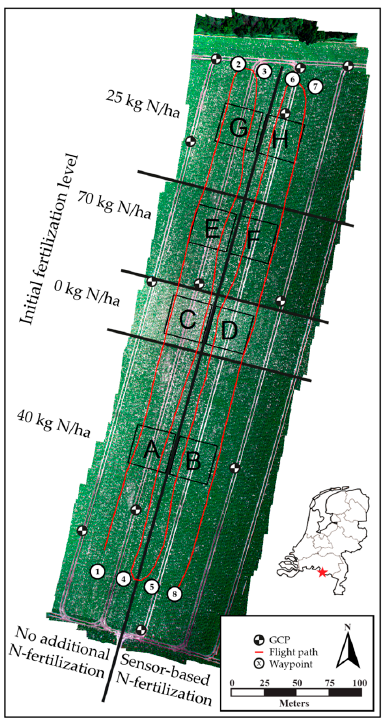
Figure 1. The eight experimental plots (A–H) in the potato field with different initial nitrogen (N) fertilization levels (horizontal zones), and additional nitrogen fertilization levels (vertical zones). The red line indicates the flight path flown during Flight 1 on 9 June 2016 (Table 2). The base map is an RGB composite (R = 674 nm, G = 559 nm, and B = 500 nm), produced with the data collected during the flight.